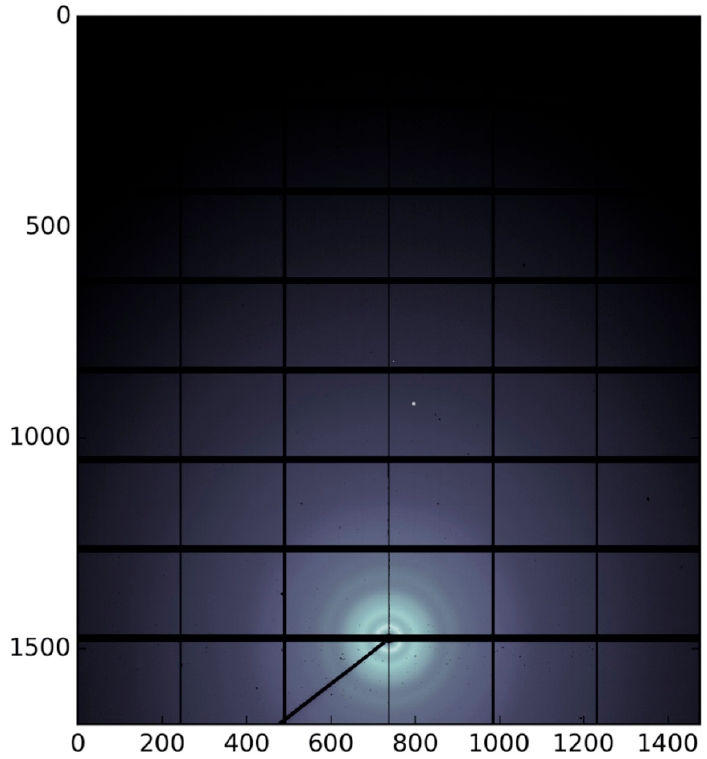
Figure A5. Raw two-dimensional images of PEDOT_SPAES_0.75.